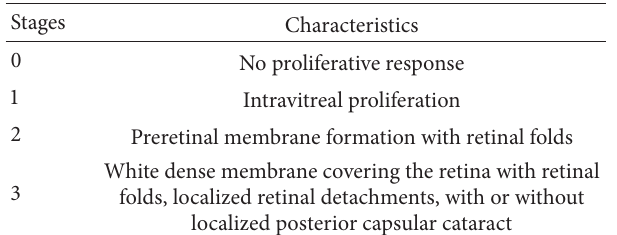
Table 2: Criteria for stages of proliferative vitreoretinopathy (adapted from